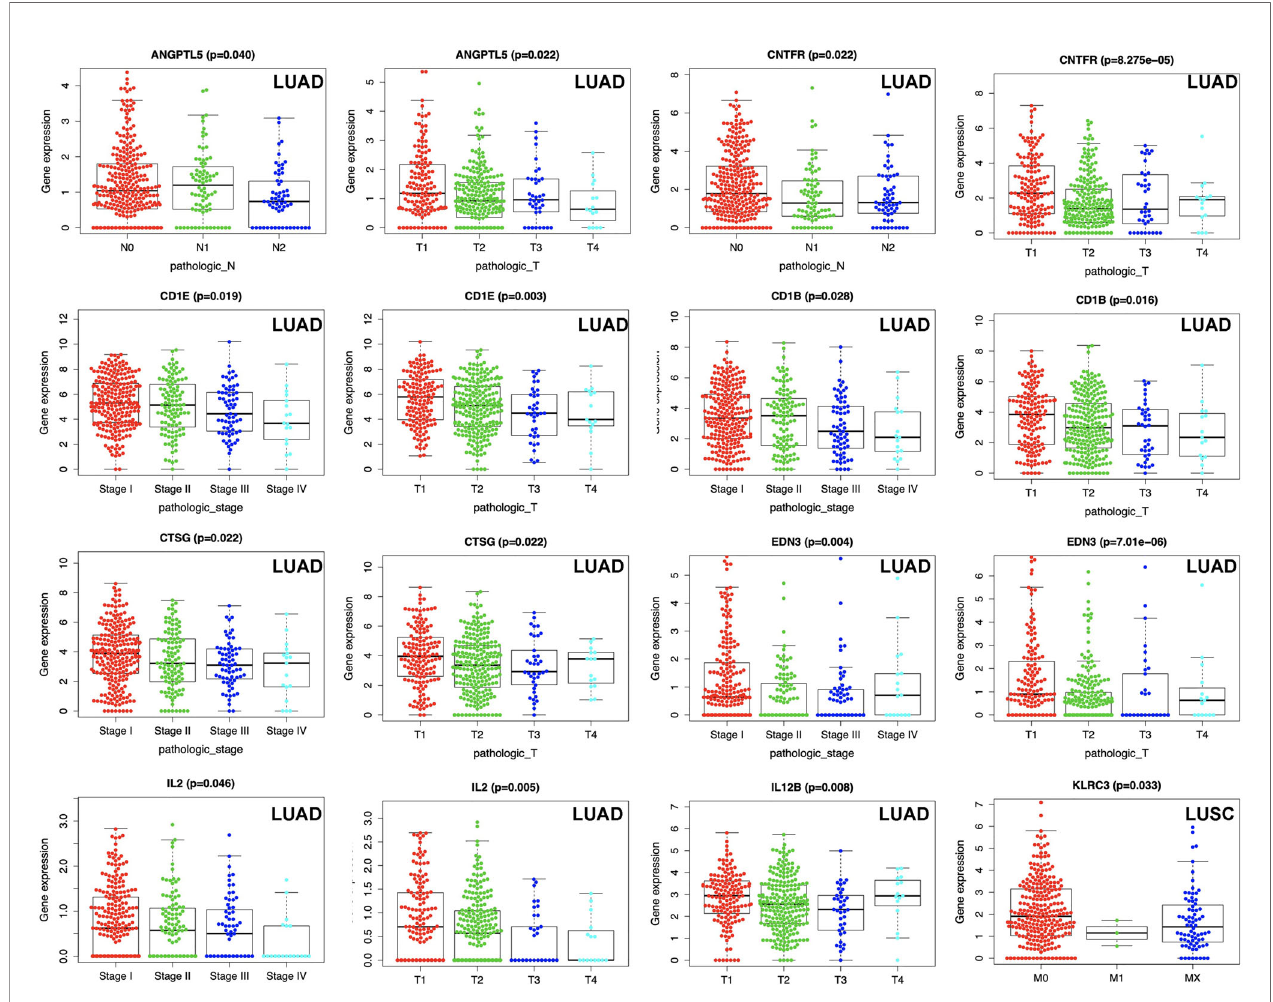
FIGURE 9 | Correlations between DEIRG expressions in prognostic model and clinical data in LUAD and